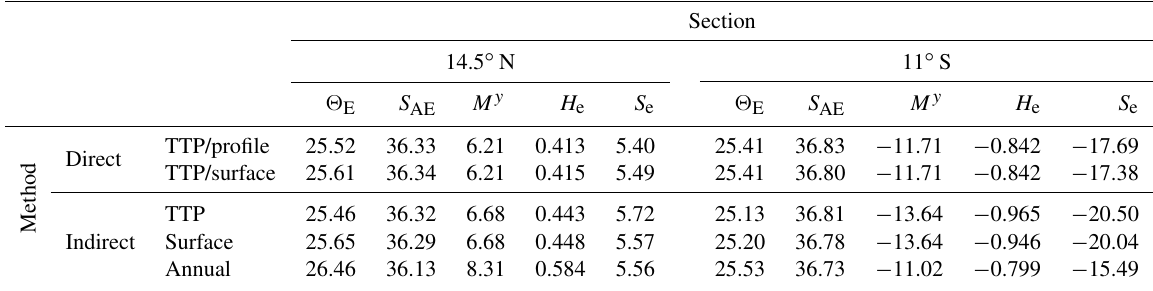
Figure 1. Positions of the CTD (magenta + ) and uCTD (blue dots) measurements along the 14.5 ◦ N and 11 ◦ S sections. The 14.5 ◦ N section was completed during RV Meteor cruises M96 (28 April to 20 May 2013, west of 20 ◦ W) and M97 (8 to 9 June 2013, east of 20 ◦ W), the 11 ◦ S section during M98 (6 to 23 July 2013). Note that the uCTD position for the 14.5 ◦ N section is artificially shifted to the north by 0.5 ◦ for visual clarity. The grey shading with contours is the mean zonal wind stress calculated from NCEP/CFSr monthly wind stress between 1979 and 2011 in Nm − 2 . Table 1. Meridional Ekman volume ( M y in Sv), heat ( H e in PW), and salt ( S e in 10 6 kgs − 1 ) fluxes calculated using different methods, and the transport-weighted temperature (cid:50) E and salinity S AE in the Ekman layer. Positive and negative fluxes denote northward and southward fluxes, respectively. The uncertainties of the Ekman heat and salt flux are 0.4PW and 45 × 10 6 kgs − 1 at 14.5 ◦ N, and 0.3PW and 65 × 10 6 kgs − 1 at 11 ◦ S, respectively. The uncertainties of the transport-weighted Ekman temperature and salinity are 0.20 ◦ C and 0.15gkg − 1 at 14.5 ◦ N, and 0.11 ◦ C and 0.10gkg − 1 at 11 ◦ S,